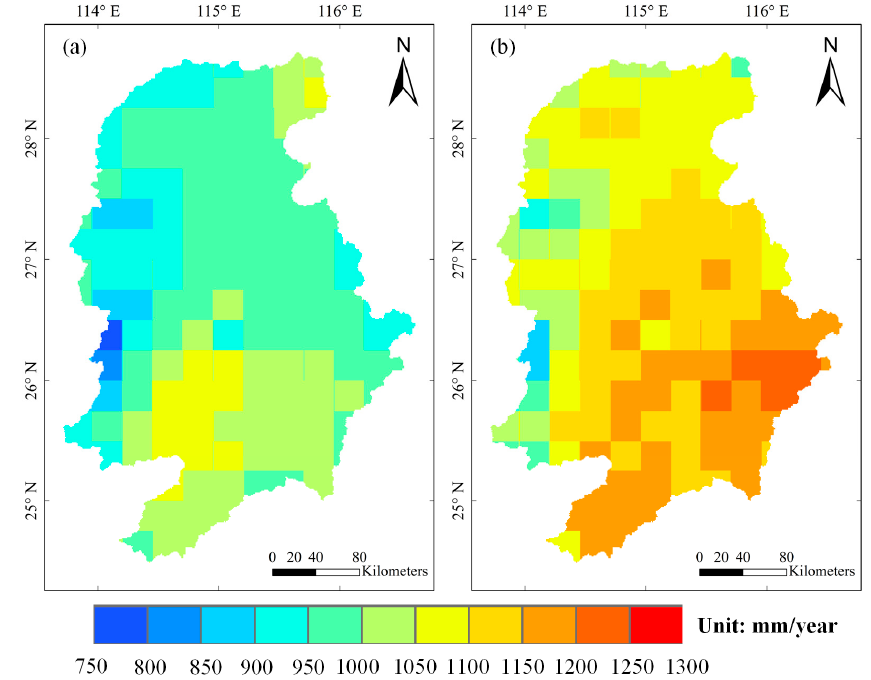
Figure 2. Spatial distribution of average annual total PET across the Ganjiang River Basin during the period of 2003–2009. ( a ) PM and ( b ) HS.